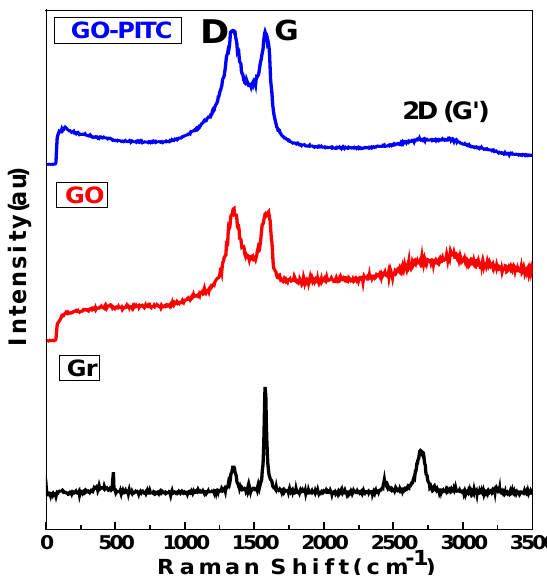
Figure 4. Raman spectra of Gr, GO and the nanocomposite GO-PEITC.